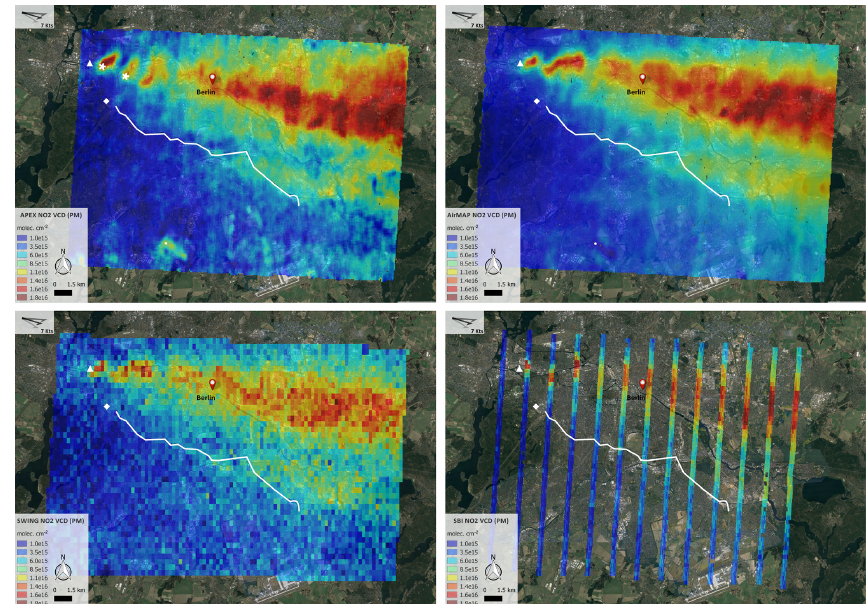
Figure 12. Tropospheric NO 2 VCD maps retrieved from APEX, AirMAP, SWING, and SBI for the afternoon flight over Berlin on 21 April 2016 (Google, TerraMetrics). The key contributing NO 2 emission sources are indicated by a white triangle (power plant Reuter West) and white diamond (Messe Berlin). The highways A100 and A113, running south of the city, are marked by the white line. Hourly averaged wind vectors indicate the surface wind at 13:00 (light grey, 3.9ms − 1 ), 14:00 (grey, 3.6ms − 1 ), and 15:00 (black, 3.6ms − 1 ) UTC. The average surface wind speed is indicated on the